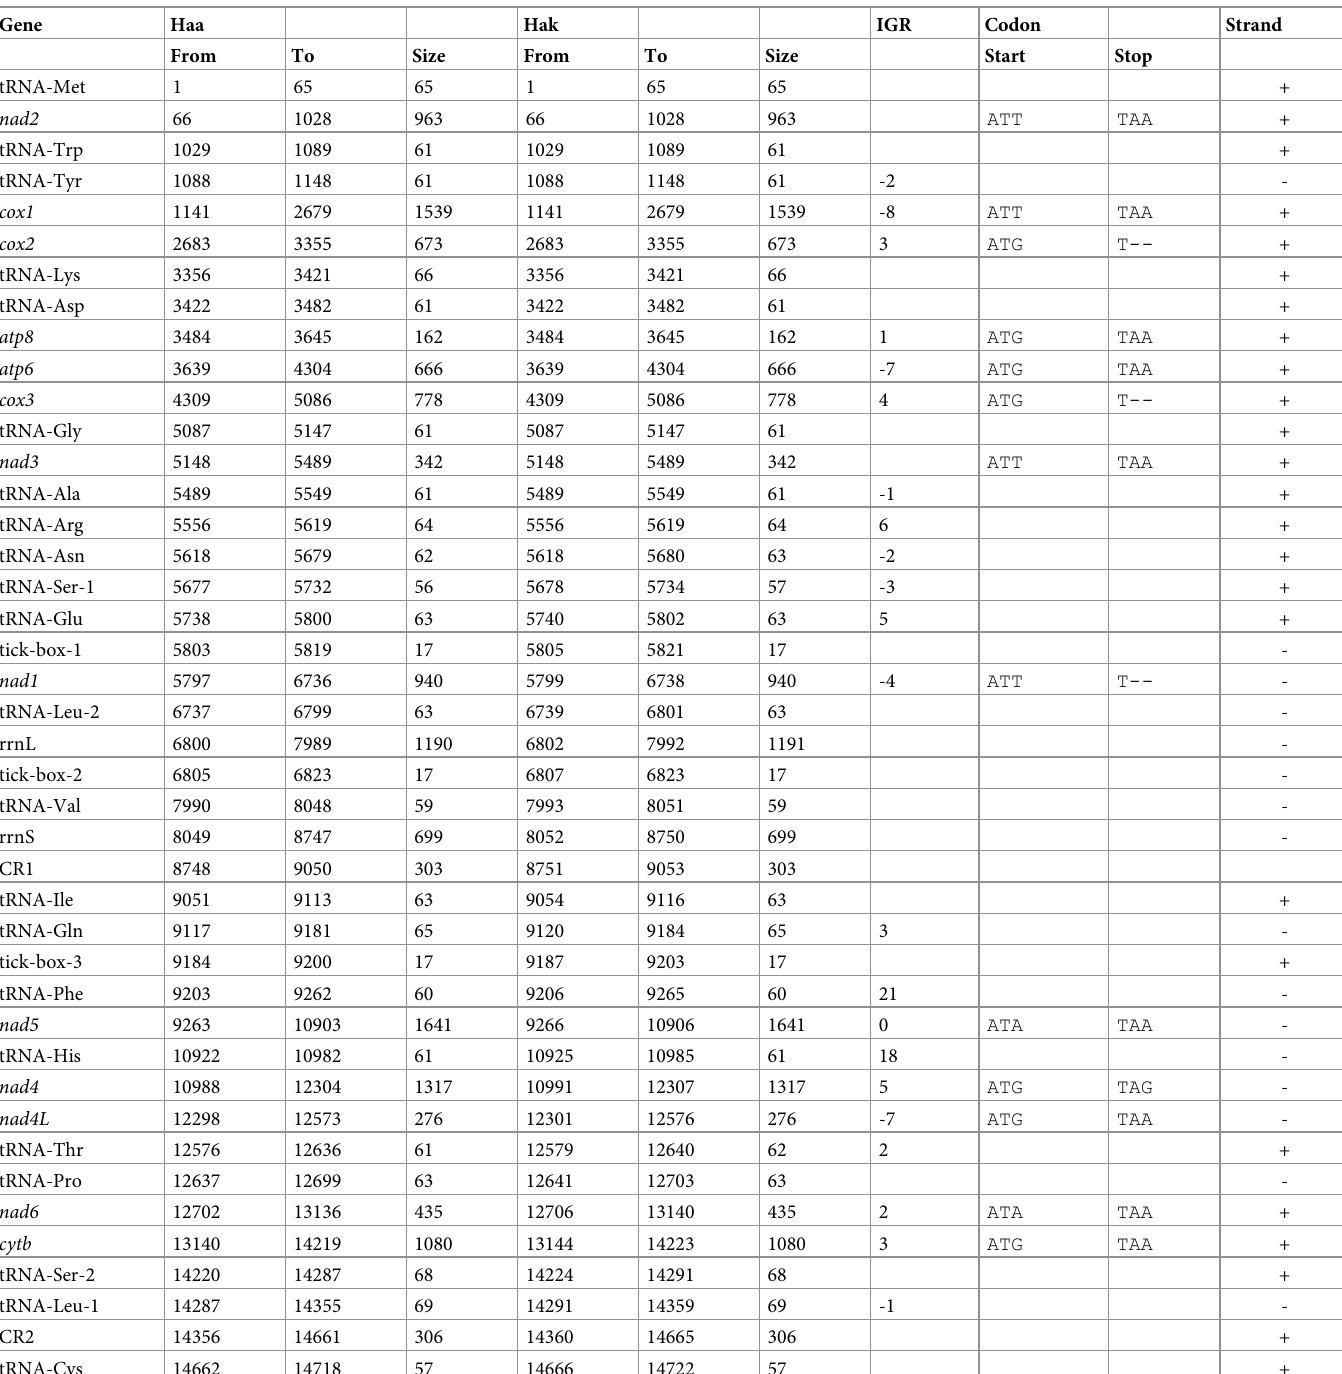
Table 1. The organization of Hyalomma asiaticumasiaticum (Haa) and kozlovi (Hak) mitochondrial genomes.